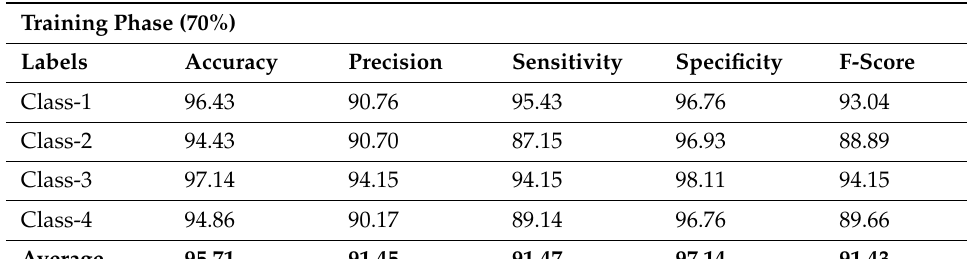
Table 3. Crowd classification outcome of the AOTL-CDA3S system with different measures under 70% of the TR database.